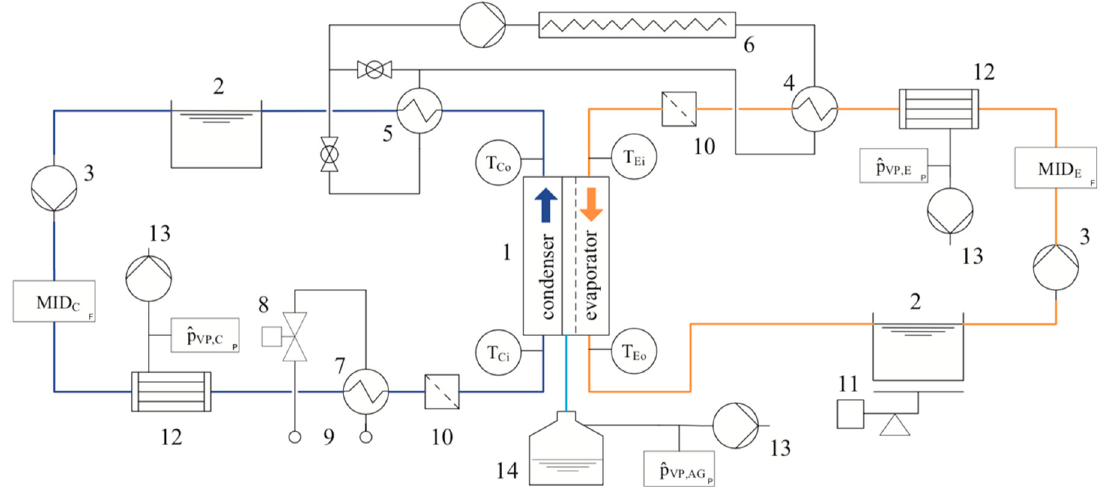
Figure 1. Hydraulic layout of the experimental setup; 1: membrane test cell; 2: feed water tank; 3: feed pump; 4: heat exchanger; 5: auxiliary heat exchanger; 6: electric heater; 7: heat exchanger; 8: motorized valve; 9: laboratory cooling circuit; 10: filter; 11: electronic balance; 12: deaeration module; 13: vacuum pump; 14: permeate tank [47].